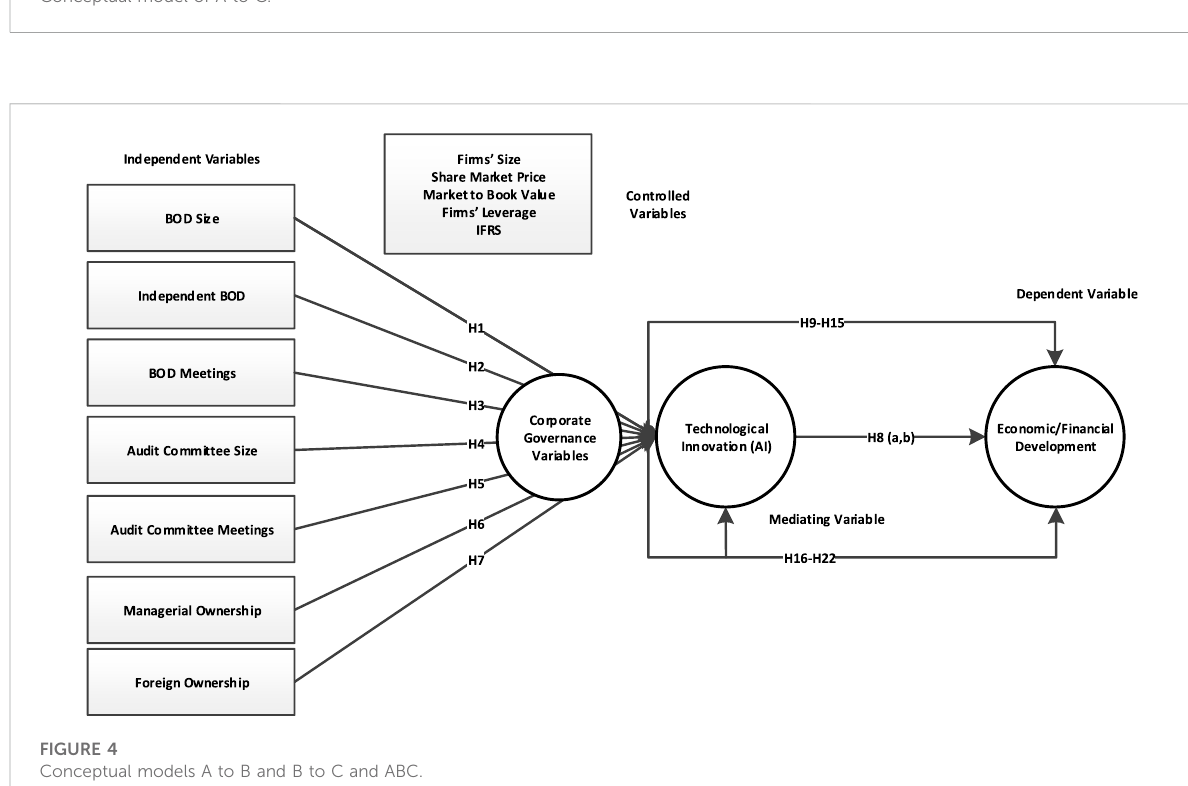
FIGURE 3 Conceptual model of A to C.